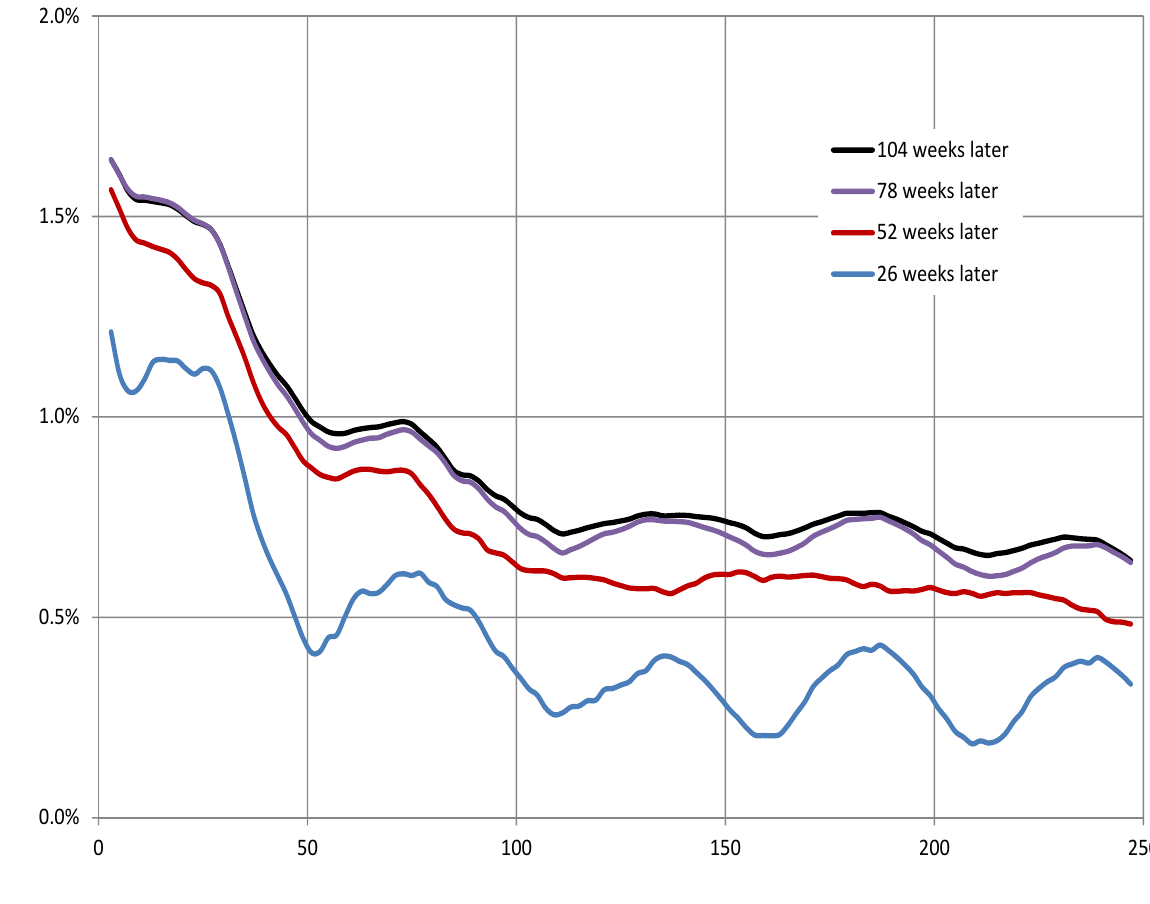
Figure 17. Ouest. The percent decrease in the total number of cases 26, 52, 78 and 104 weeks after the beginning the second round of vaccination indicated on the abscissa. The onset of the immune response was assumed to begin a week later. We assume 70% efficacy of the vaccine. Percent reduction in cases after vaccination, the 2nd dose given in the indicated week (50,000 vaccinated over 5